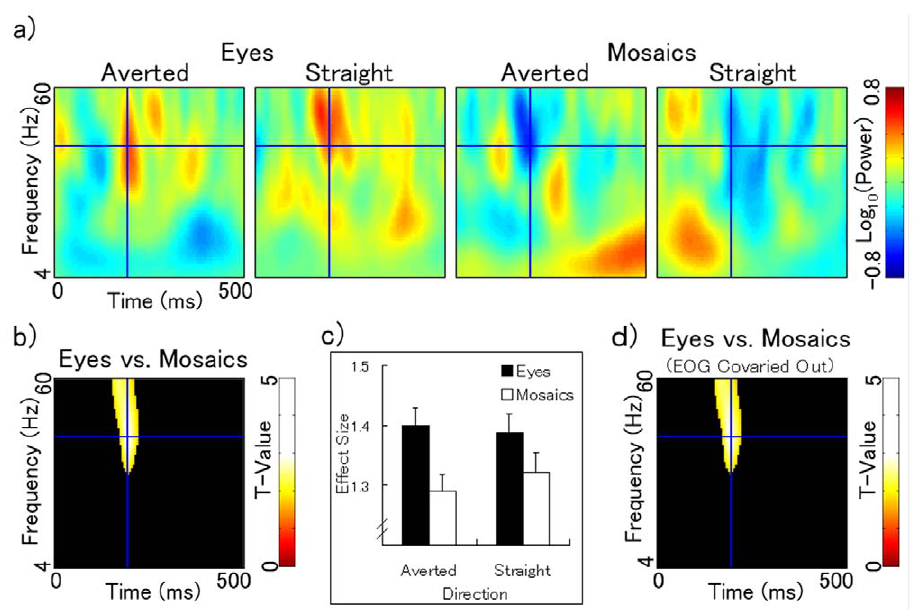
Figure 3. Amygdala activity under the first stimulus presentation condition. a) Adjusted time–frequency maps of the amygdala for averted eyes, straight eyes, averted mosaics, and straight mosaics under the first stimulus presentation condition. The results for both hemispheres are combined. Blue crosses indicate the locations of activation foci for the main effects of stimulus type, contrasting the effects of eyes versus mosaics (200 ms, 44 Hz). b) Statistical parametric maps that exhibited higher activation for eyes than for mosaics. A blue cross indicates the location of activation focus. c) Mean (with SE) effect size at the peak activation focus of the amygdala. The results of both hemispheres are combined. d) Statistical parametric maps that exhibited higher activation for eyes than for mosaics in the analyses after covarying out the gamma-band horizontal and vertical EOGs. A blue cross indicates the location of activation focus.